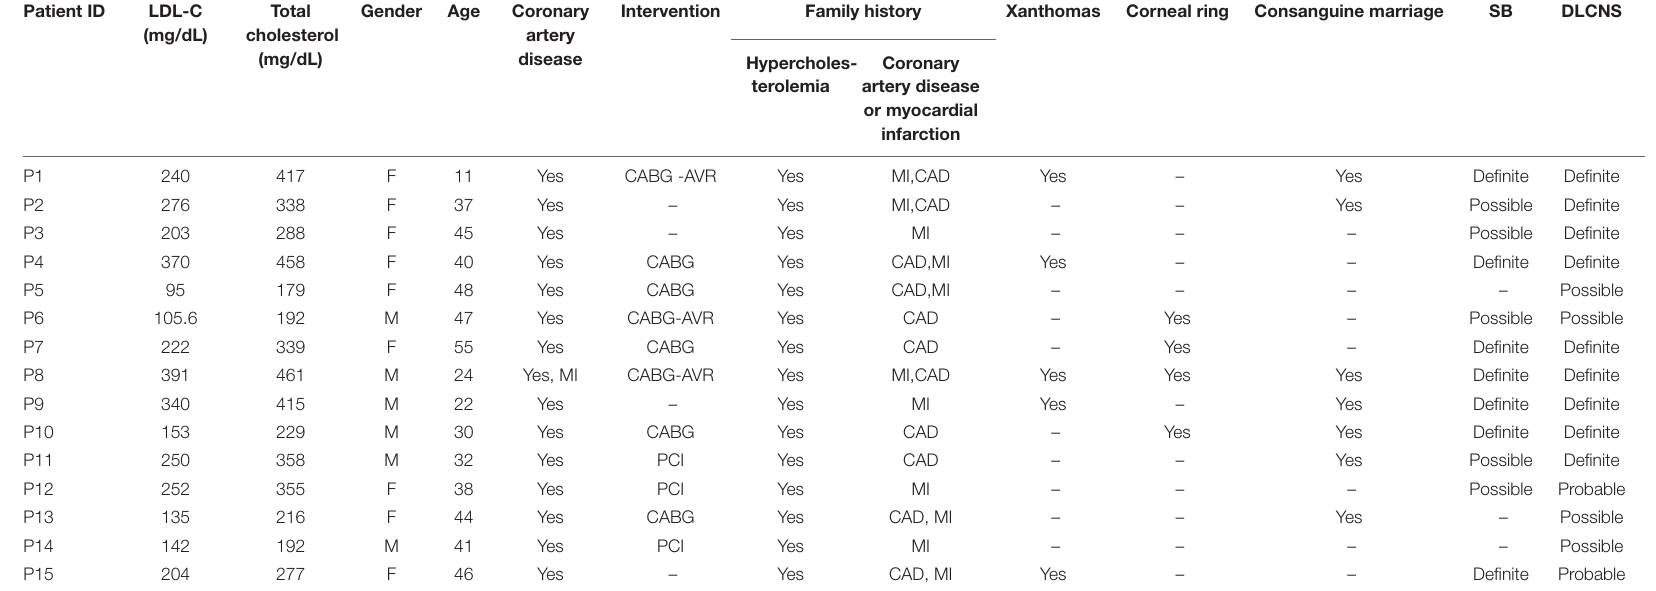
TABLE 1 | Clinical characteristics of the enrolled patients. Patient